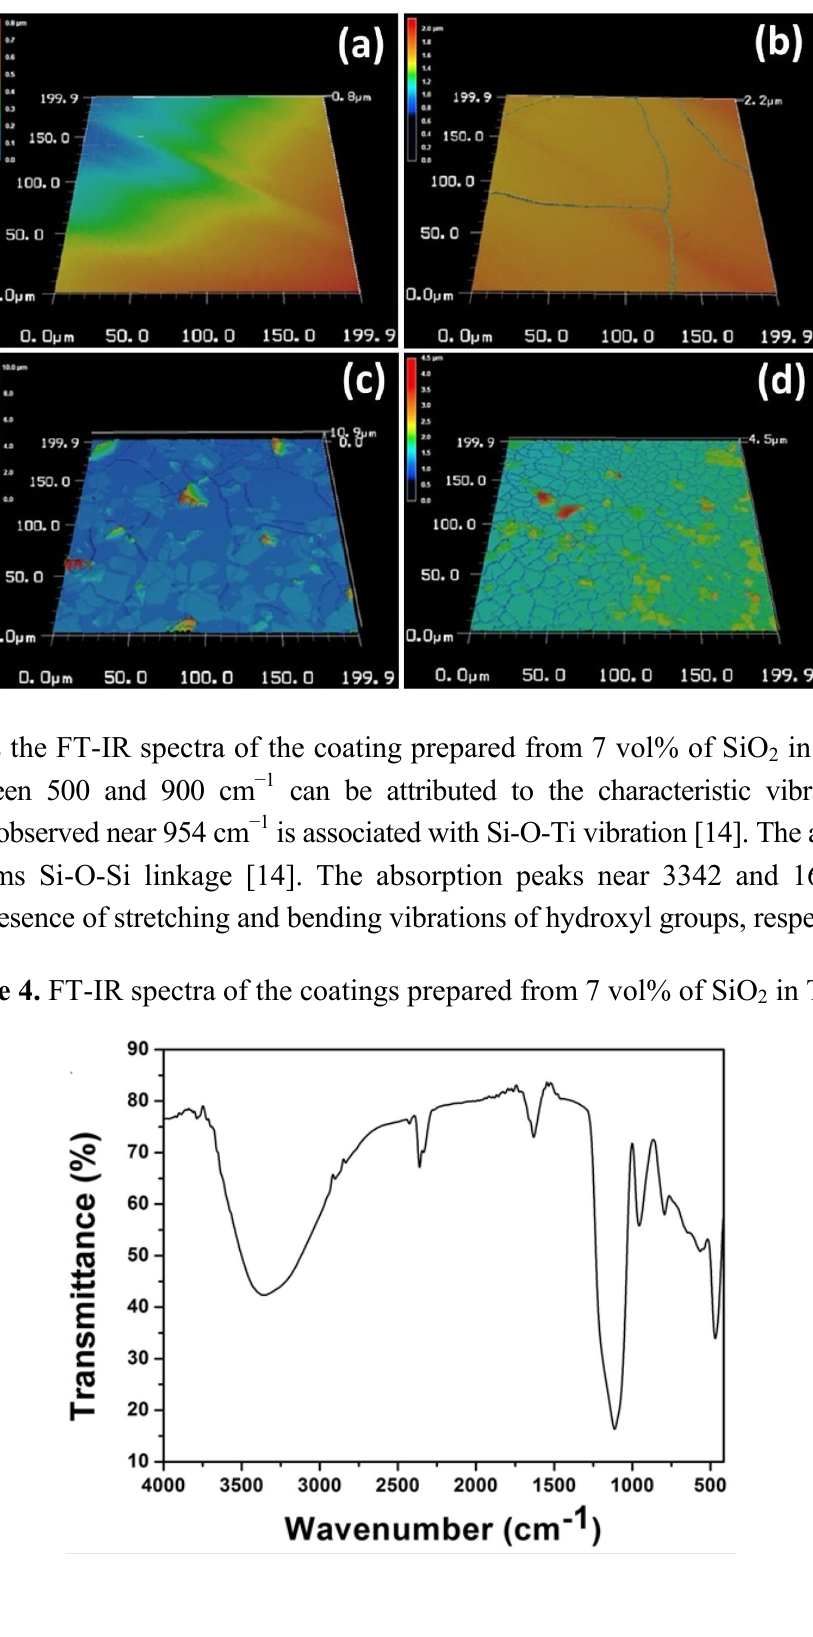
Figure 3. 3D Laser microscope images of the coatings prepared from ( a ) 7; ( b ) 10; ( c ) 15; and ( d ) 20 vol% of SiO